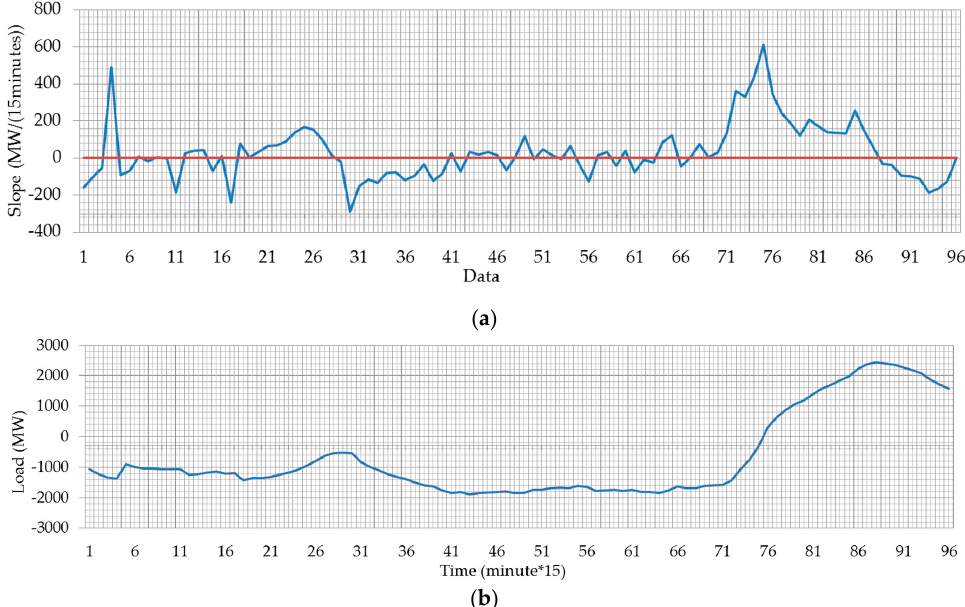
Figure 4. Net load curve and the adjacent point slope of 11 April, ( a ) The consecutive point slope; ( b ) The net load curve.